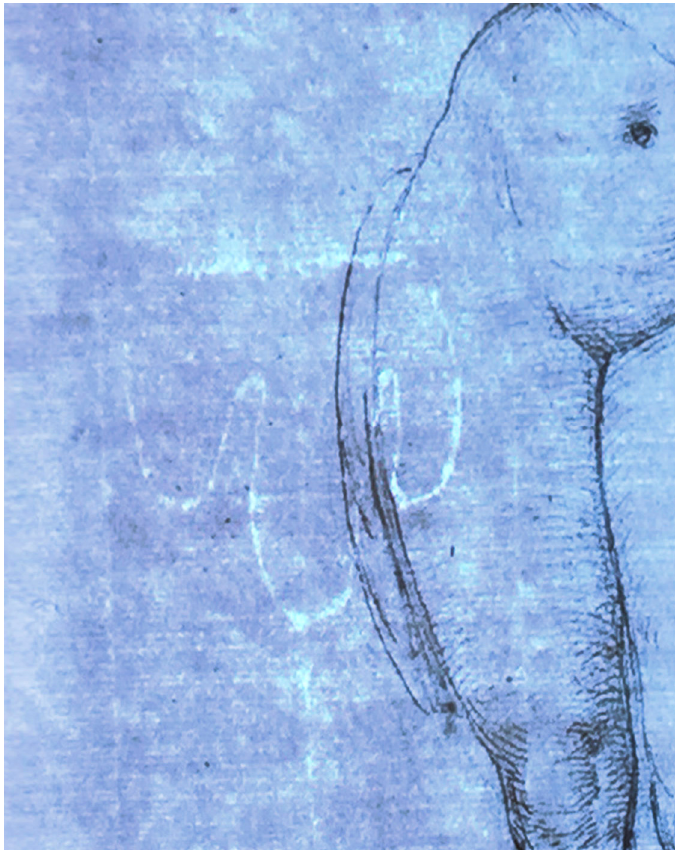
Figure 4. Raphael, Leda and the Swan, ca. 1507, pen and ink over black chalk underdrawing, 210 × 192 mm, RCIN 912759, Royal Collection, Windsor Castle. Royal Collection Trust/© Her Majesty Queen Elizabeth II 2021. Detail of the watermark “ three aligned mountains ” in transmitted light exposure. Used with permission. Image in transmitted light created by author.